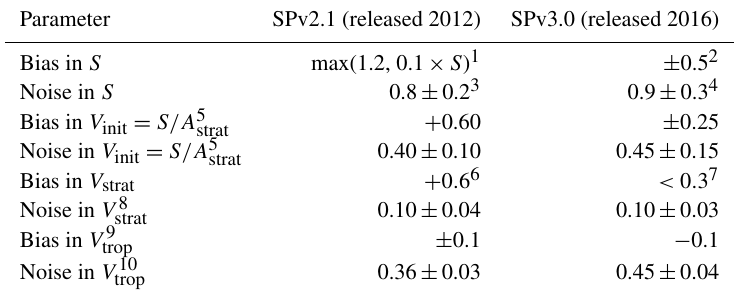
Table 2. SP NO 2 retrieval biases and noise estimated over unpolluted, mostly cloud-free (cloud radiance fraction < 0.3) Pacific Ocean regions in July 2011 ( × 10 15 molec.cm − 2 ).